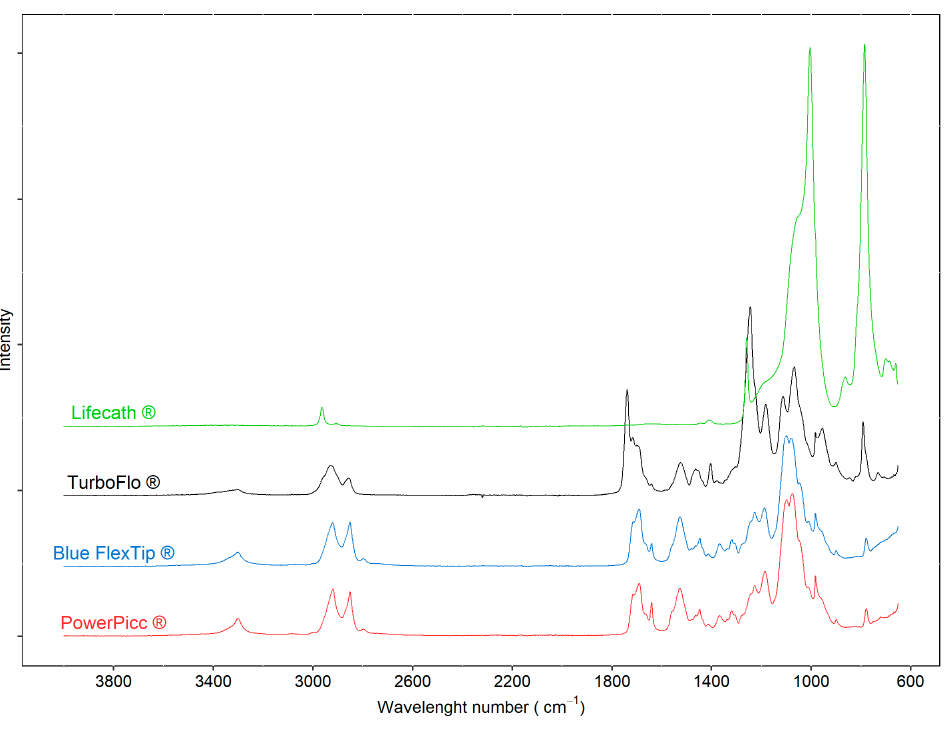
Figure 2. ATR-FTIR spectra of the inner surface of polyurethane (Blue: Blue FlexTip ® ; Red: PowerPicc ® ; Black: Turbo-Flo ® ) and silicone catheters (Green: Lifecath ® ).